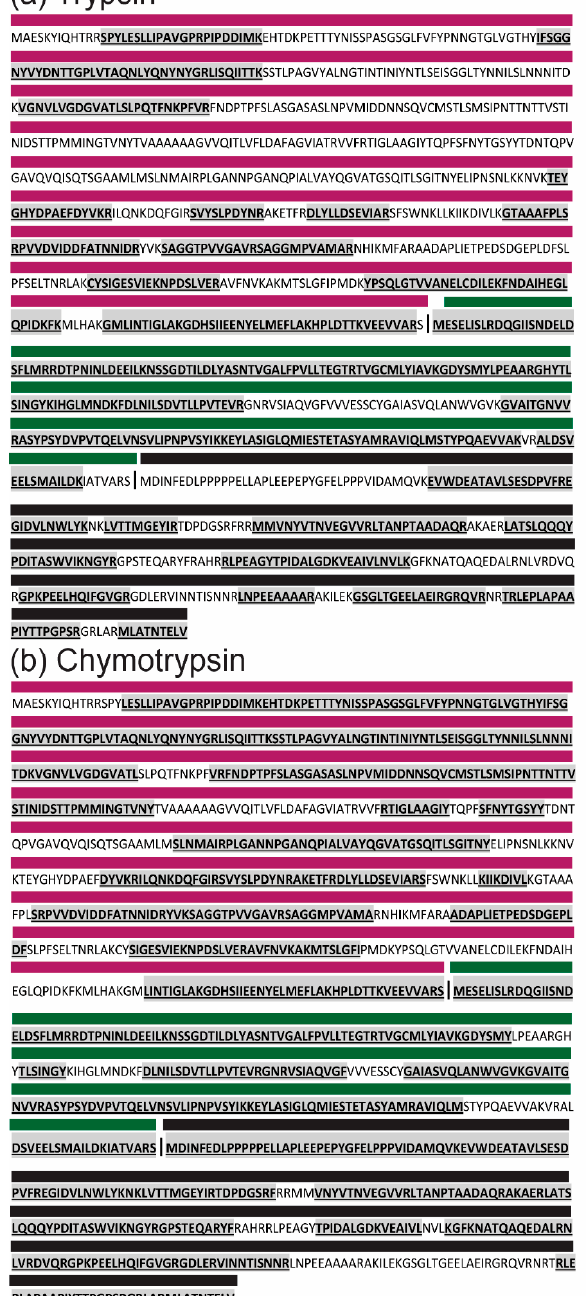
Figure 5. Digestion of ABV proteins by trypsin and chymotrypsin. Schematic showing ABV polyprotein sequence identified by mass spectrometry following digestion with ( a ) trypsin or ( b ) chymotrypsin. Sequence detected by mass spectrometry is highlighted in grey and underlined. Colored bars above sequence denote predicted individual proteins: pVP2, magenta; VP4, green; VP3,